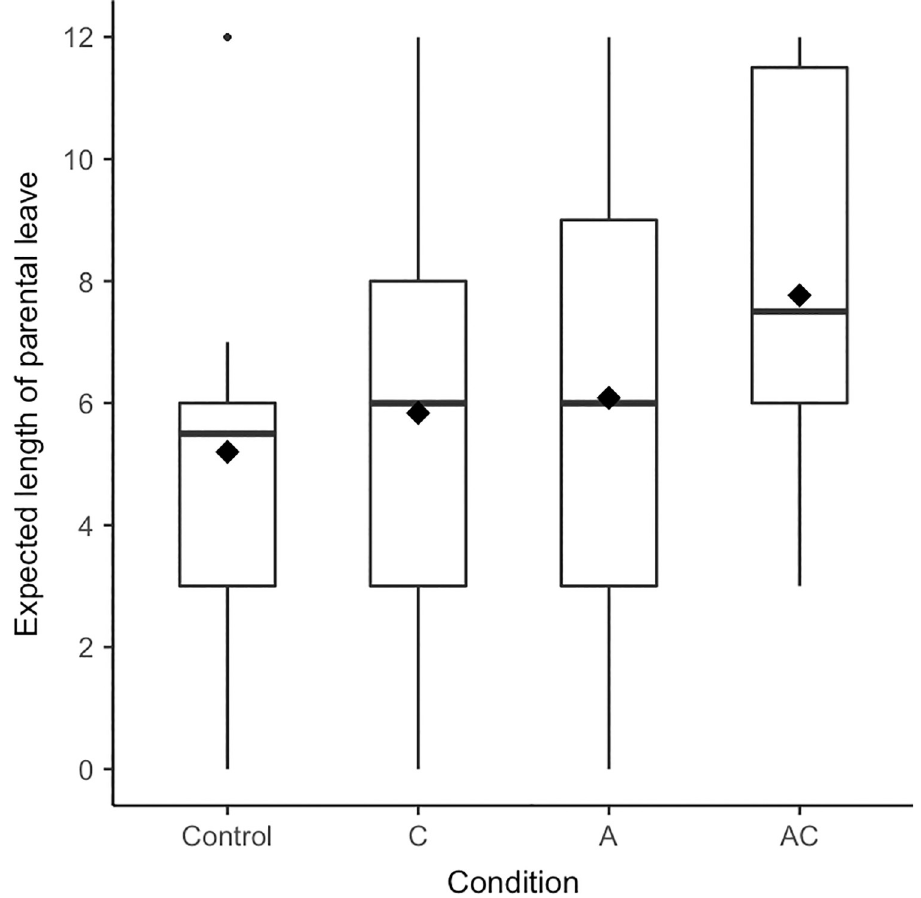
Fig 2. Boxplots for expected length of parental leave separated by condition (Experiment 1). Diamonds represent means, horizontal lines represent medians.